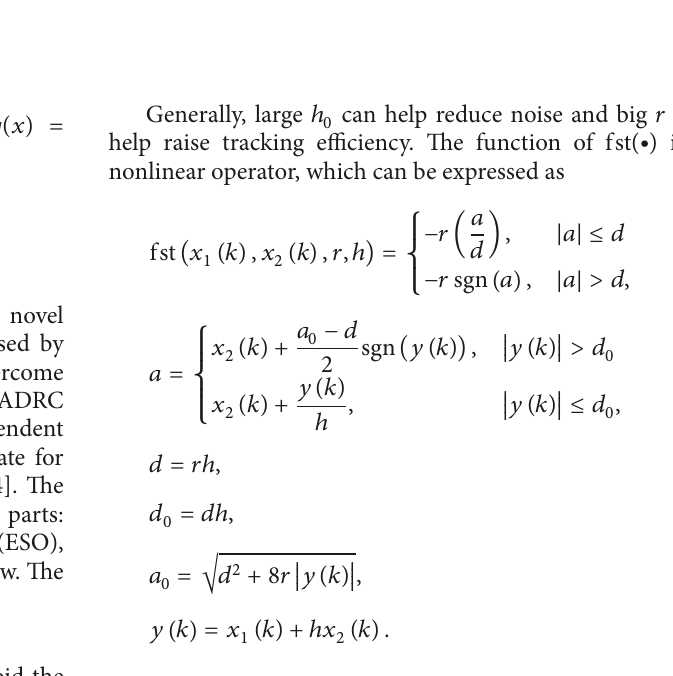
Figure 2: Schematic diagram of the